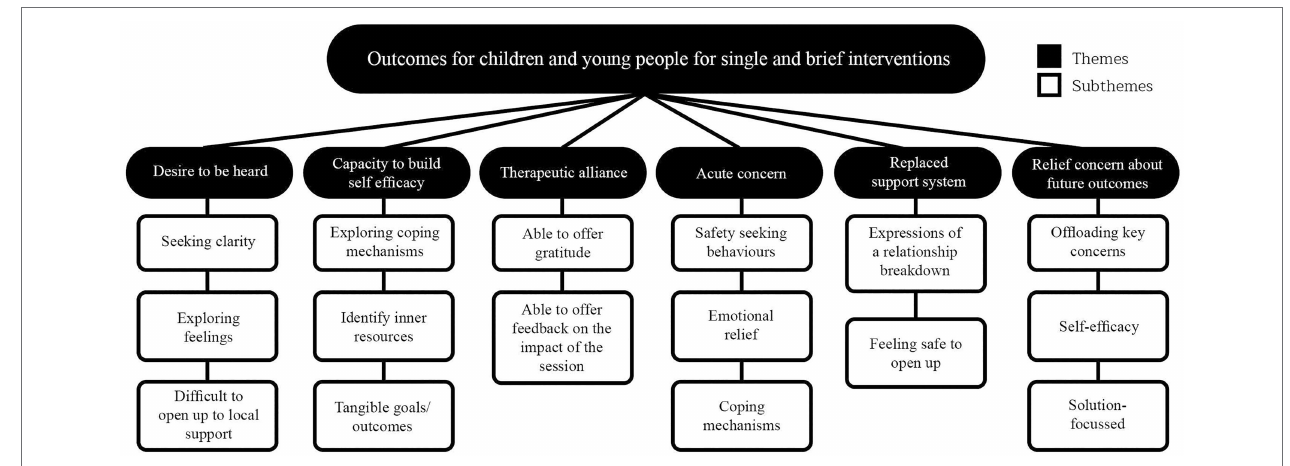
FIGURE 2 | Thematic tree for single and drop-in brief interventions in